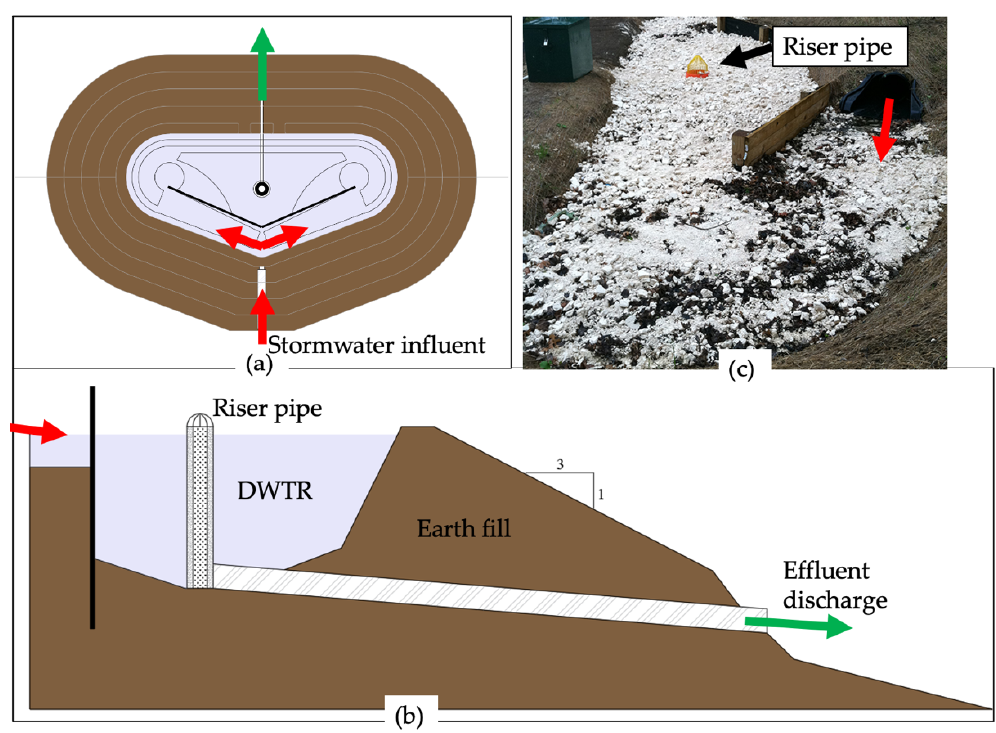
Figure 1. The P removal structure with spent lime DWTR, as depicted in ( a ) plan view, ( b ) cross section, and ( c ) actual photograph after construction.